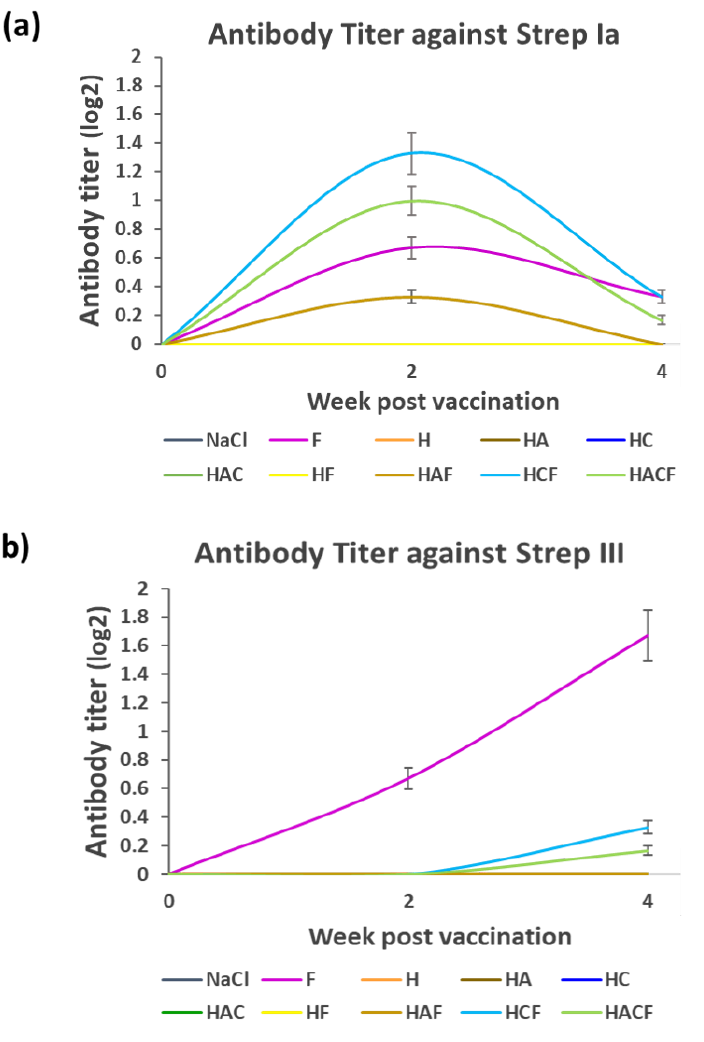
Figure 4. Antibody titer determination at week 2 and 4 post-vaccination: ( a , b ) the antibody titer levels against S. agalactiae serotype Ia and III (Strep Ia and III), respectively. Data are represented as the means ± SDs (n = 3; n represents three replicated aquarium tanks). F: fish injected with the StrepKU-1 vaccine marked as a positive control, NaCl: fish fed with 0.85% NaCl solution marked as a negative control.